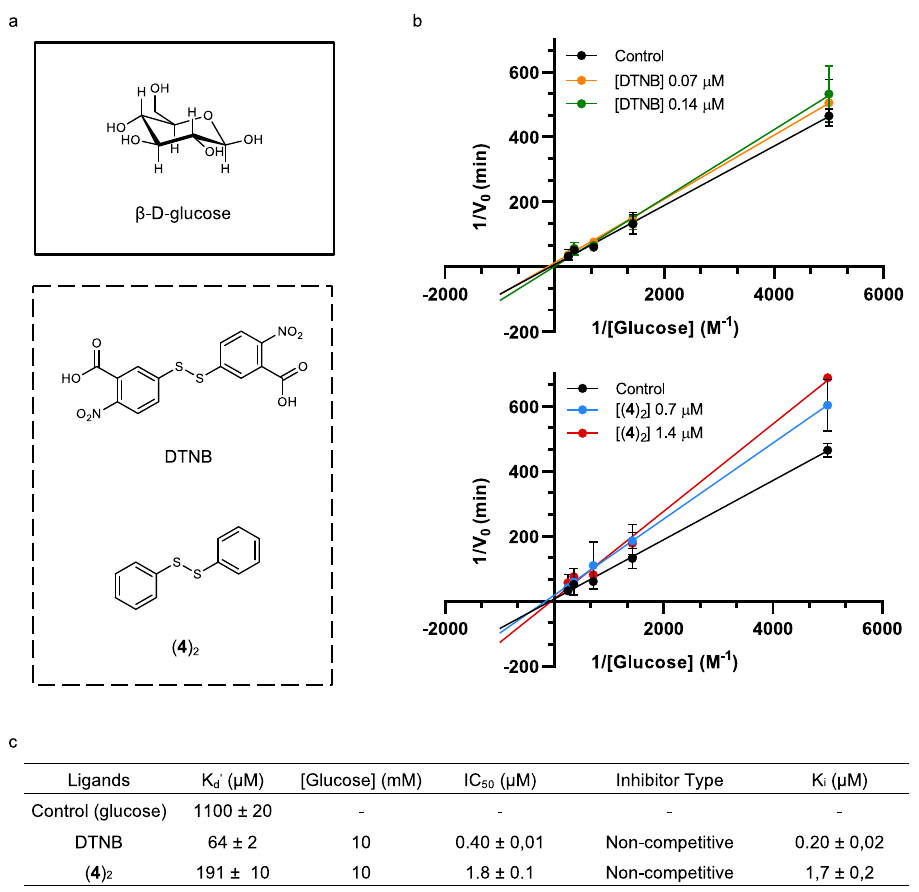
Fig. 10 Enzyme activity and binding assays. a Structures of substrate β - D -glucose and the studied inhibitors DTNB and ( 4 ) 2 of glucose oxidase. b Lineweaver – Burk plots 57 of DTNB and ( 4 ) 2 . Conditions: [glucose] from 0.2 to 4 mM, 37 °C at 50 mM sodium acetate buffer pH 5.15, [DTNB] 0.07 and 0.14 µ M, [( 4 ) 2 ] 0.7 and 1.4 µ M. Mean ± SD from four independent experiments. c Summary of the binding af fi nity and enzymatic activity parameters (Supplementary Methods). Source data are provided as Source Data fi